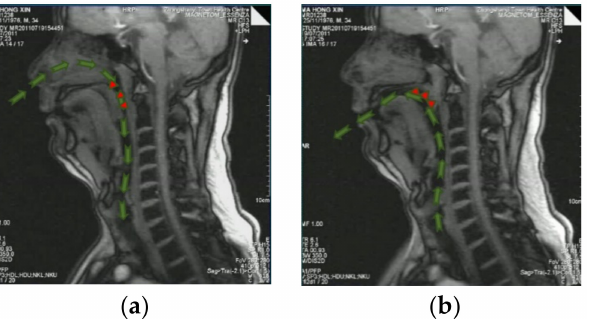
Figure 6. One-way valve effect of an OSAHS patient. ( a ) Act of inhaling; ( b ) exhaling. Green arrows indicate the airflow